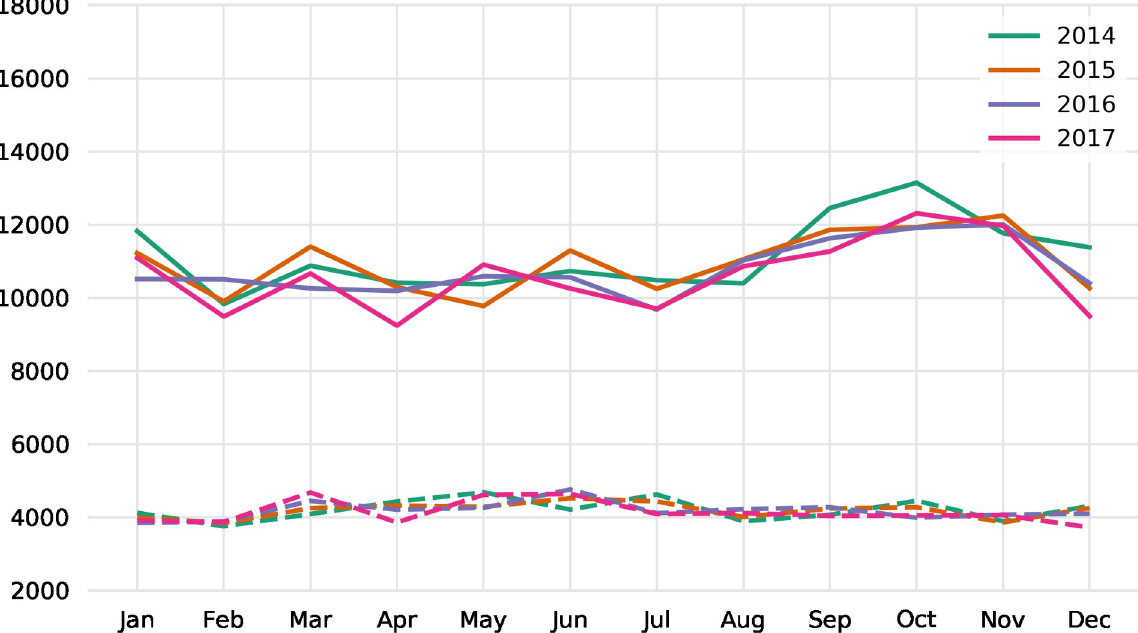
Fig 3. Number of movements per month. Movements to slaughterhouses are plotted with solid lines and movements to holdings other than slaughterhouses are plotted with dashed lines.